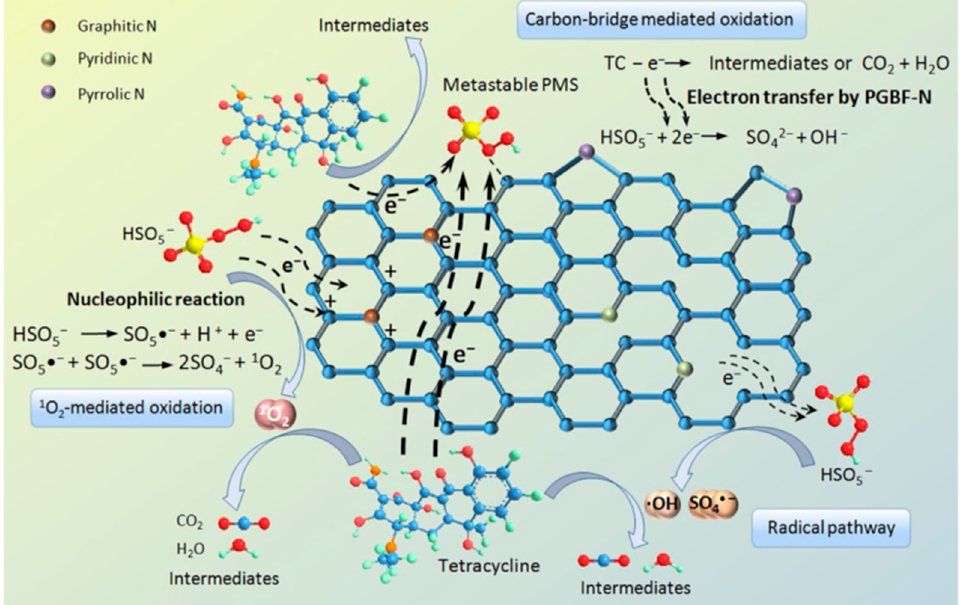
Figure 8. Proposed mechanism of PMS activation by PGBF-N for the degradation behavior of TC molecules [85], copyright 2020, Elsevier.